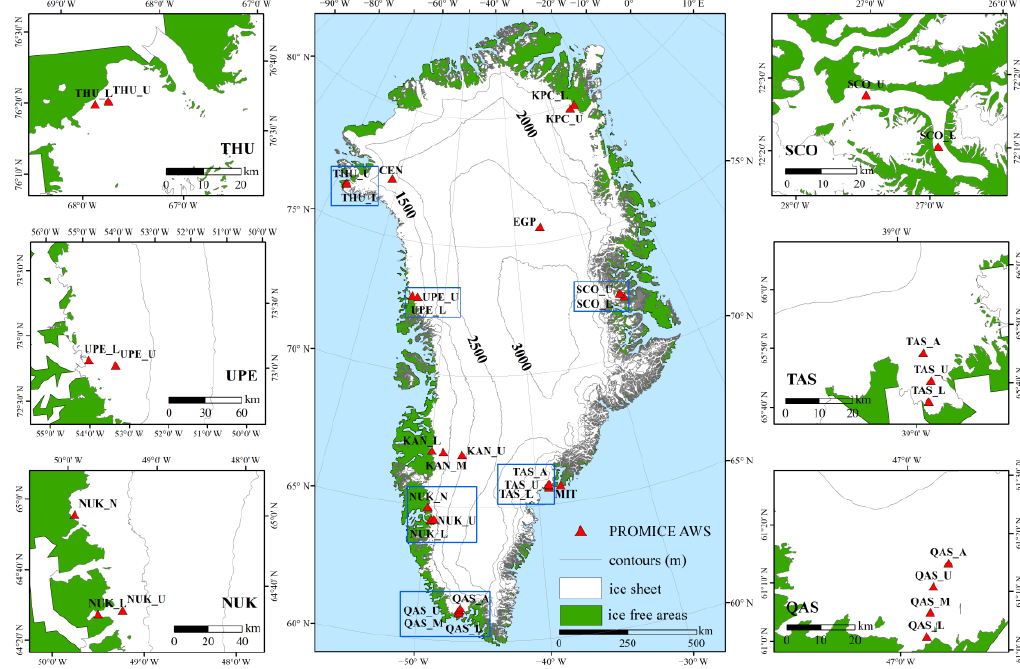
Figure 1. Map of Greenland showing the elevation and locations of the PROMICE AWS. Six transects are magnified in subplots. Table 1. Geographical characteristics of the meteorological stations used in this study.